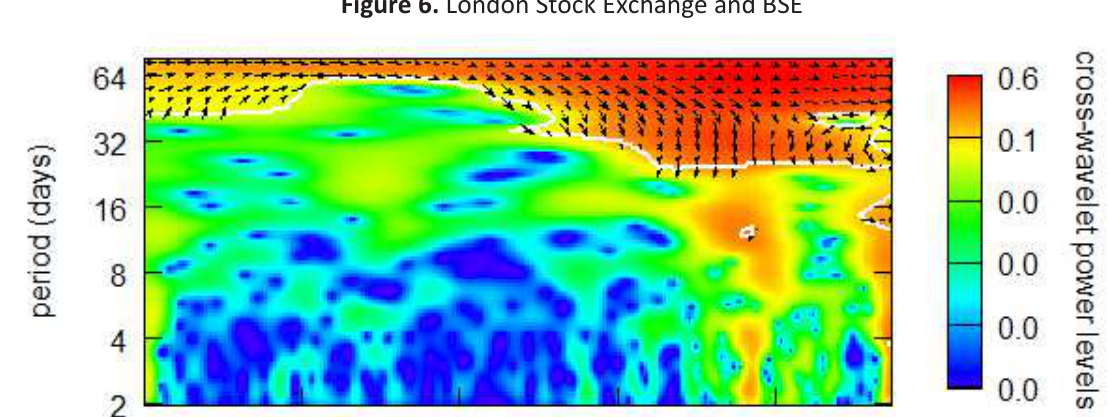
Figure 6. London Stock Exchange and BSE